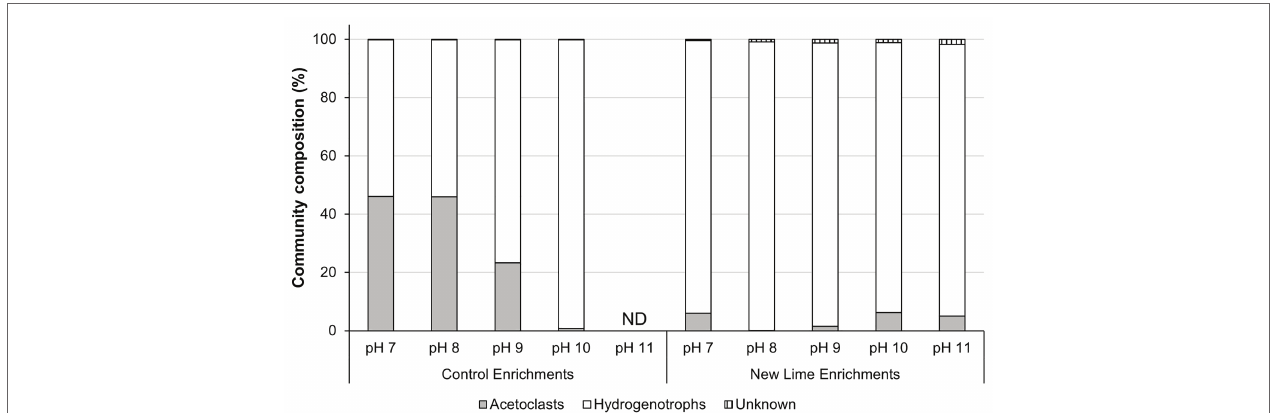
FIGURE 2 | Methanogen communities in neutral and alkaline soil enrichments. When the neutral pH Control sediment was enriched with CDP the acetoclastic and hydrogenotrophic communities were present in roughly equal proportions at pH 7.0 and 8.0, respectively. As the pH increased to pH 10.0, the acetoclastic compostion fell as pH increased, with no methanogen community detectable at pH 11.0. In contrast the alkaline New Lime enrichments were dominated by hydrogenotrophic methanogens irrespective of enrichment pH (ND, none determined).